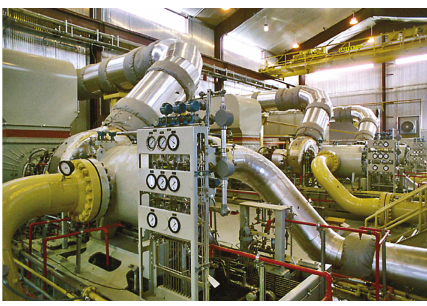
Figure 1: Typical compressor station with 3 gas turbine driven centrifugal